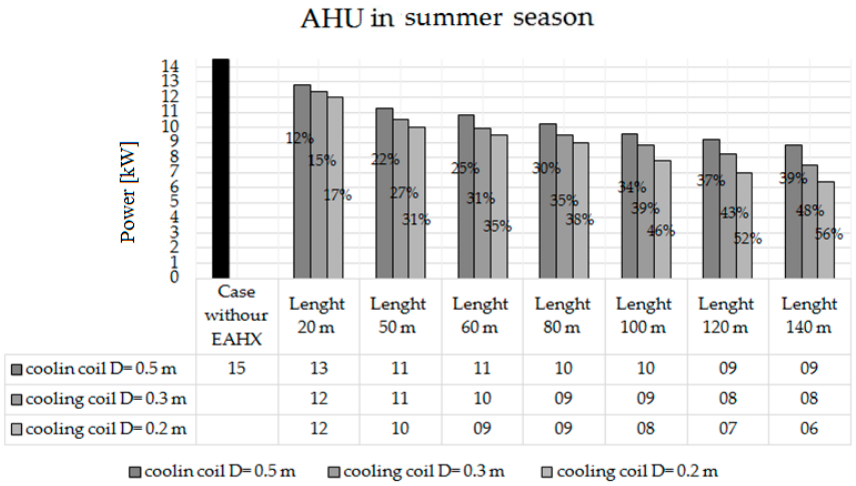
Figure 11. Power of cooling coil and relative percentage of reduction by varying diameter and length of buried tubes during summer season.